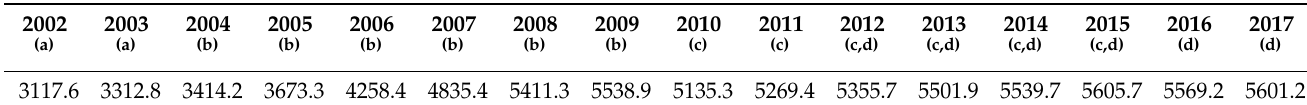
Table 1. Reported area harvested to sugarcane (1000 ha), 2002 and 2017. Data from the Agricultural Economics Institute (IEA) of the State of S ã o Paulo Secretariat of Agriculture; Area Harvested to Sugarcane (1000 ha). Data from the 2005 (a), 2010 (b), 2016 (c), and 2019 (d) reports [49,76–78]. 2002 2003 (a)